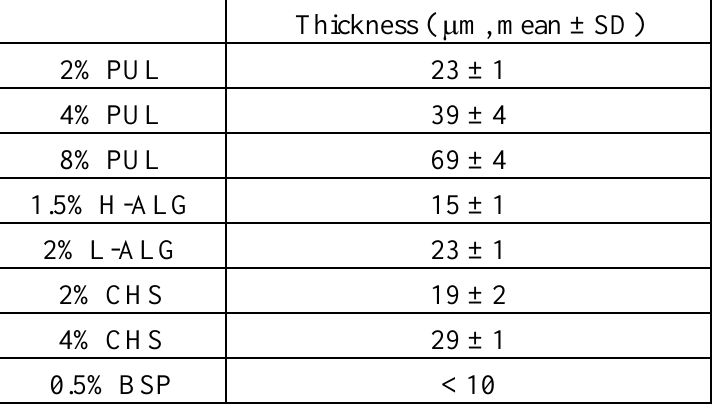
Table 2. Thicknesses of films prepared with various